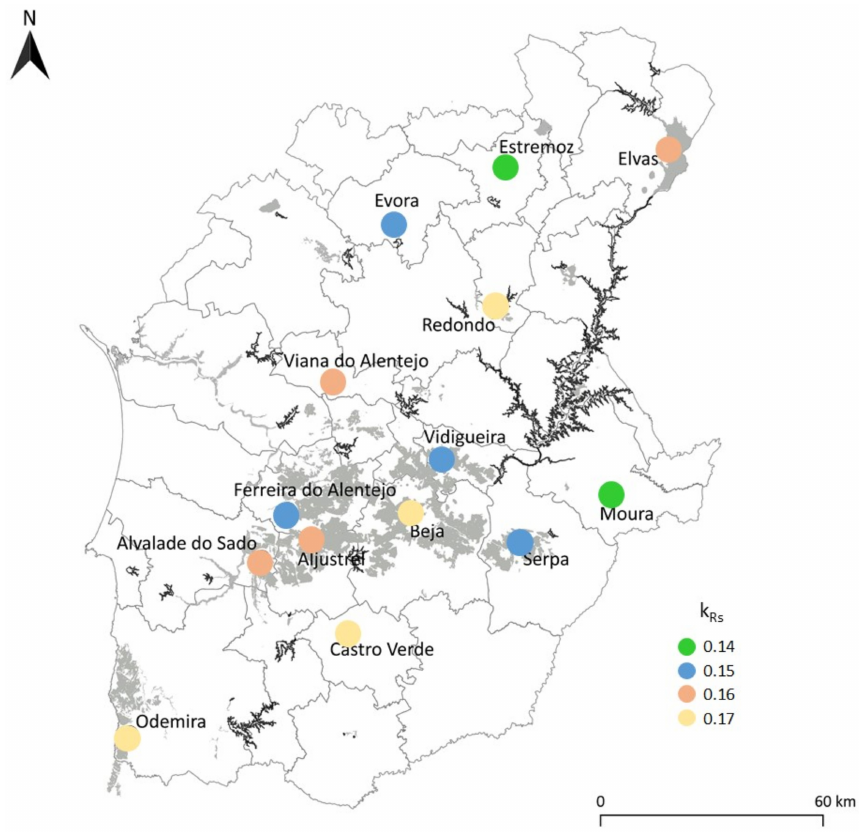
Figure 2. Calibrated and validated radiation adjustment coefficient k Rs for each location.